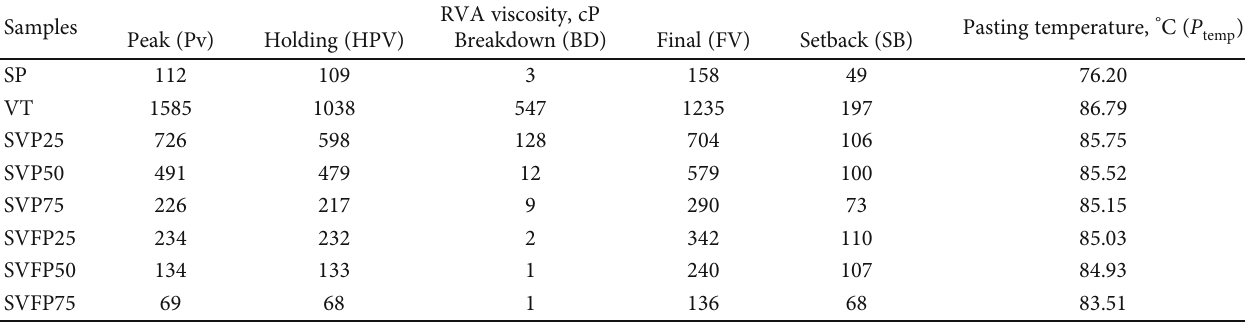
RVA viscosity, cP